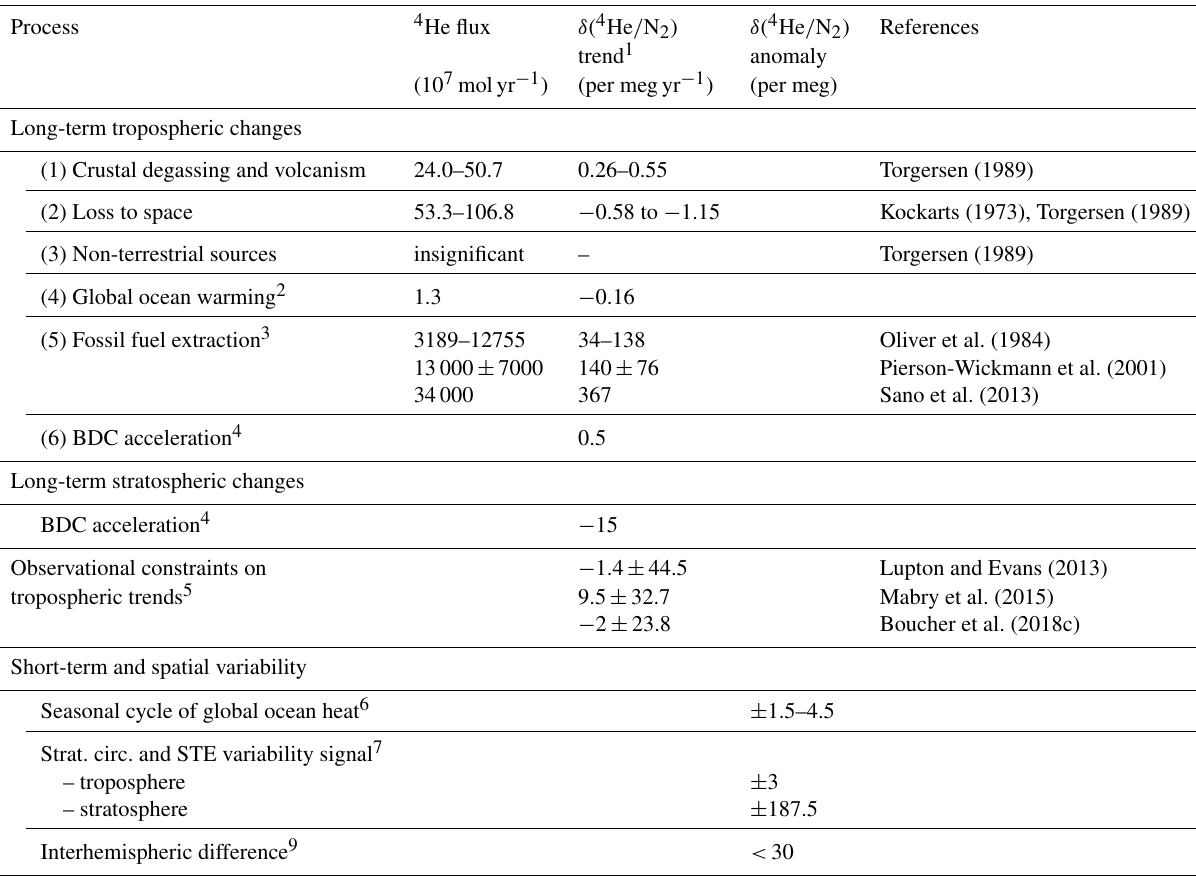
Table 1. Processes contributing to variations in the tropospheric and stratospheric 4 He / N 2